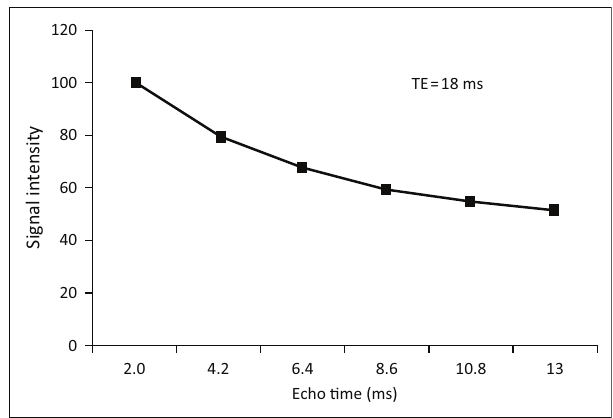
FIGURE 14: Signal intensity to echo time graft of the T2 * analysis with the sample points for the ROI at each TE time having a smooth continuous